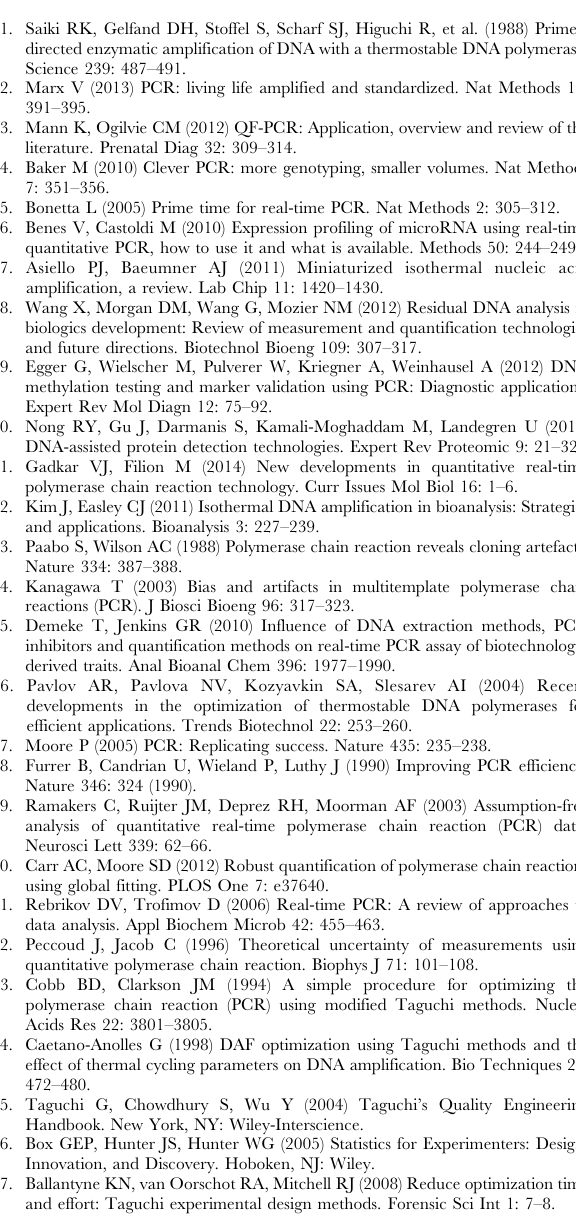
Table S1 Original non-linear amplicon-count data for PCR profiling of epidemiological typing of